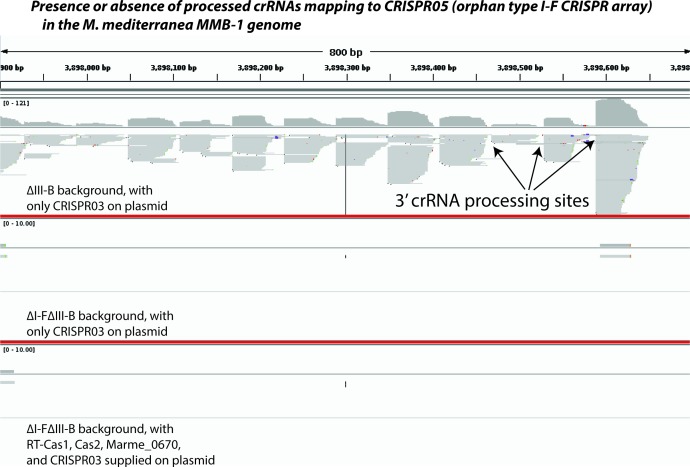
Type I-F pre-crRNA from the orphan array is not processed in the absence of type I-F factors.Screenshot from Integrated Genome Viewer (IGV) showing an 800 bp portion of the orphan type I-F CRISPR05 array in the M. mediterranea MMB-1 genome (chromosomal coordinates 3,897,900–3,898,700). Small RNAs were selected and sequenced using a protocol that preserves strand information, controls for PCR amplification bias, and faithfully reports the 3’ ends of source RNA molecules. Sequencing reads were mapped to the entire genome. Screenshot depicts pileups of reads mapping uniquely to the CRISPR05 region from three different experiments separated by thick red lines (corresponding to Figure 4F,H and I respectively). ∆III-B denotes removal of the entire type III-B operon; additionally, the entire I-F operon (including the linked CRISPR04 array) is removed in the ∆I-F∆III-B background. Plasmid-supplied type III-B factors are listed in each panel. CRISPR05 was left intact in all strains. A few crRNA processing sites are highlighted by arrows.